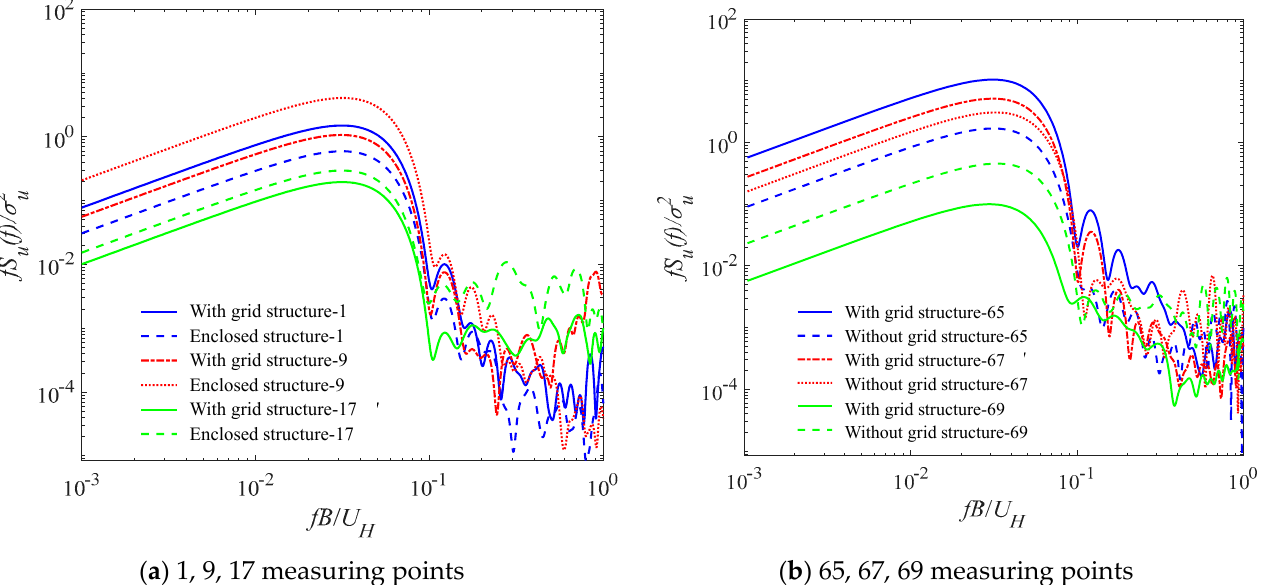
Figure 29. Normalized power spectra of fluctuating wind pressure at typical measuring points on the 50 m layer at a 0° wind direction angle.